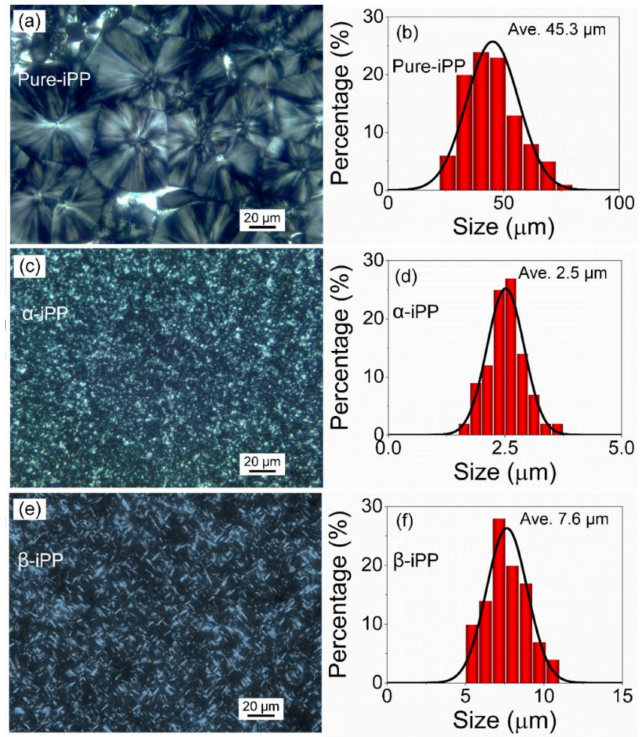
Figure 1. POM images and the size distribution of crystalline agglomerates of ( a , b ) Pure-iPP, ( c , d ) α -iPP, and ( e , f ) β